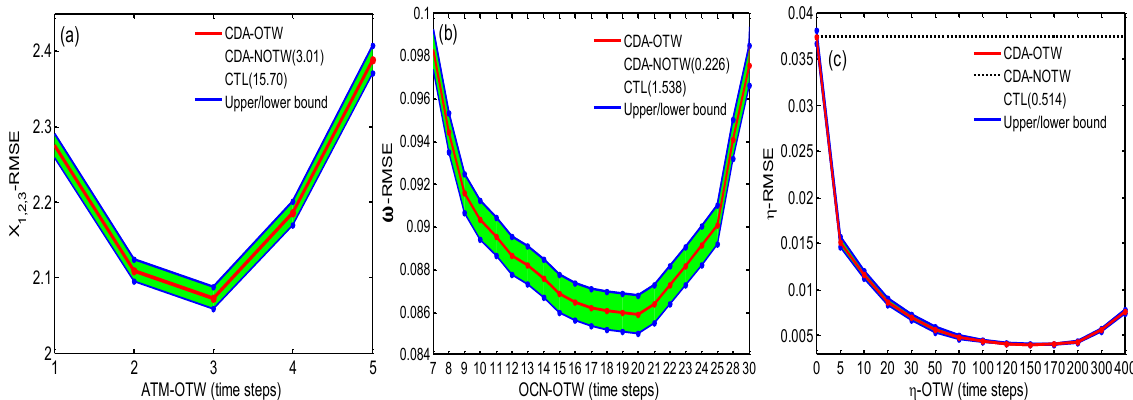
Figure 8. Same as Fig. 4 but using the biased model setting. In panel (b) the optimal ATM-OTW is set as 3. And in panel (c) the optimal ATM-OTW and OCN-OTW are kept as 3 and 20, when the “deep ocean” observations are assumed to be